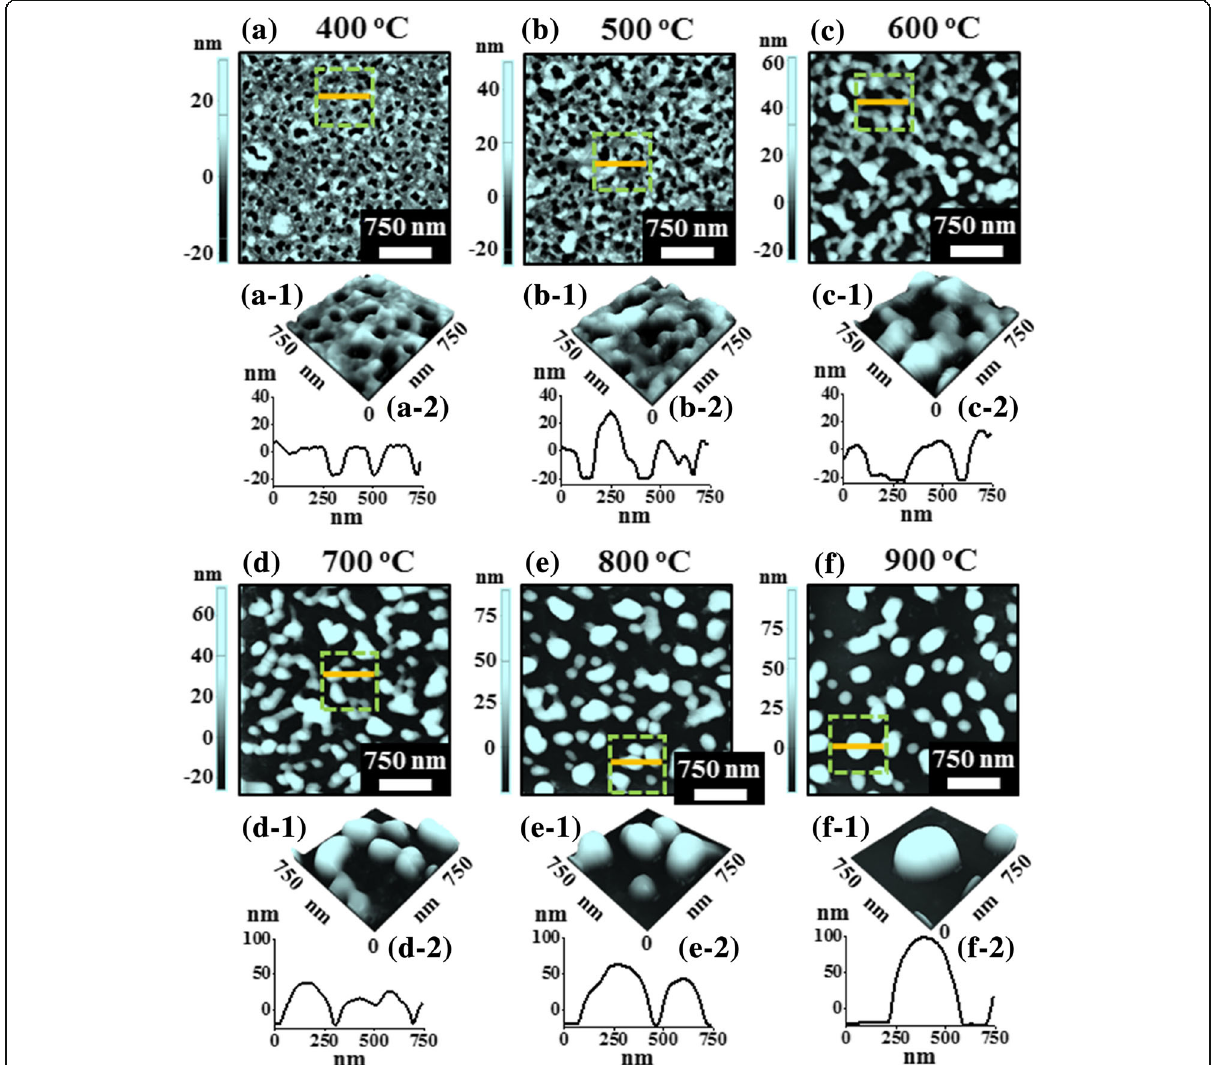
Fig. 4 PdAuAg nanostructures based on the multi-layers of 15 nm Pd/Au/Ag films (15 layers) with 1 nm each. The annealing temperature was systematically varied between 400 and 900 °C for 450 s (multi-layers). a – f AFM top views (3 × 3 μ m 2 ). a-1 – f-1 Magnified AFM side views (750 × 750 nm 2 ). a-2 – f-2 Cross-sectional line